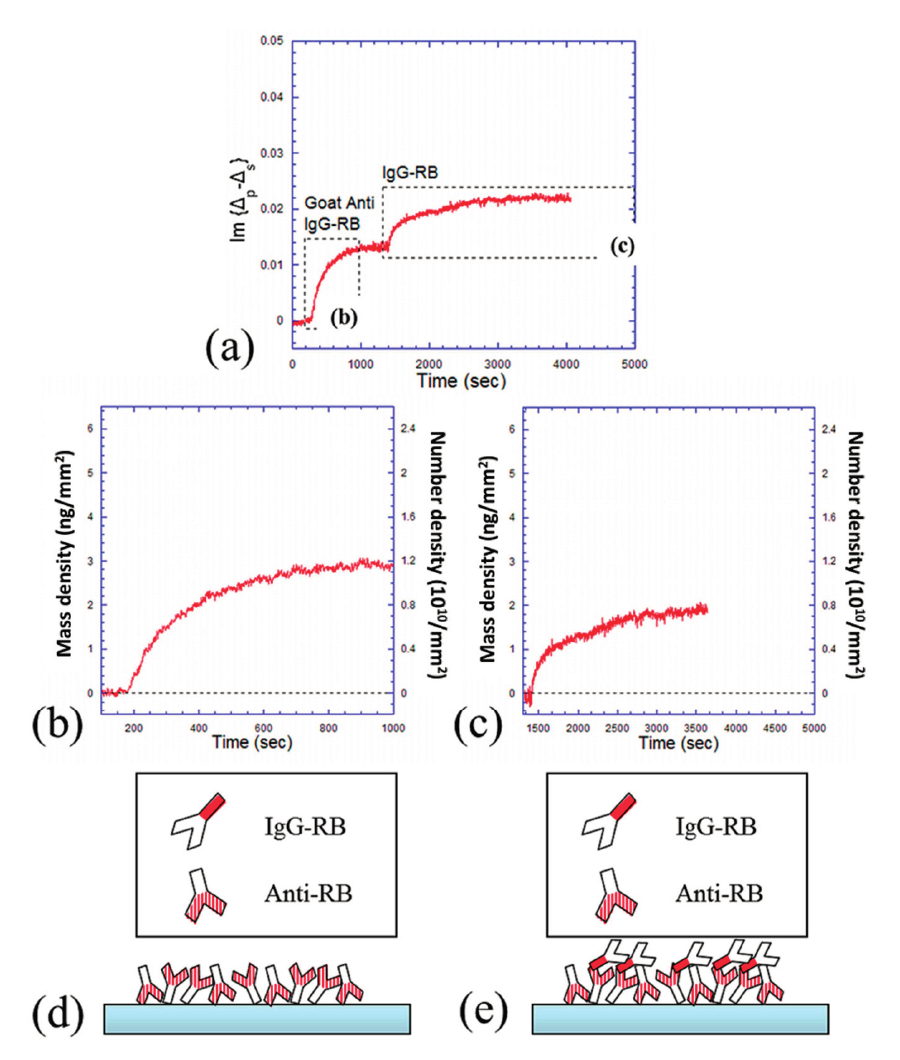
Figure 4. Kinetics of antigen-antibody capture. ( a ) OI-RD detection of antibody (33 nM of Goat Anti-RB) binding to epoxy surface and following antigen (67 nM of IgG-RB) binding to antibody; ( b ) Kinetic curve of Goat Anti-RB binding to epoxy surface; ( c ) Kinetic curve of IgG-RB binding to Goat Anti-RB; ( d ) Cartoon depiction of process (b); ( e ) Cartoon depiction of process